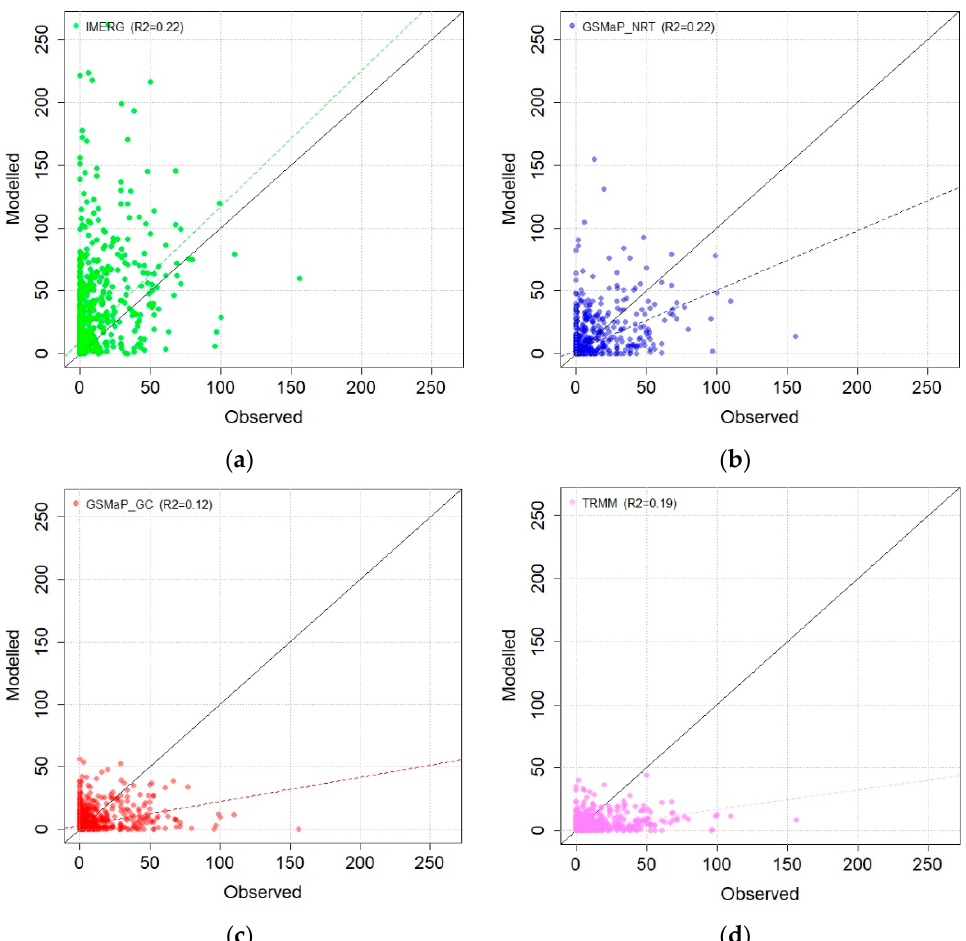
Figure 4. Scatter plots of satellite-based daily precipitation datasets of ( a ) IMERG; ( b ) GSMaP_NRT; ( c ) GSMaP_GC; and ( d ) TRMM compared to observation.